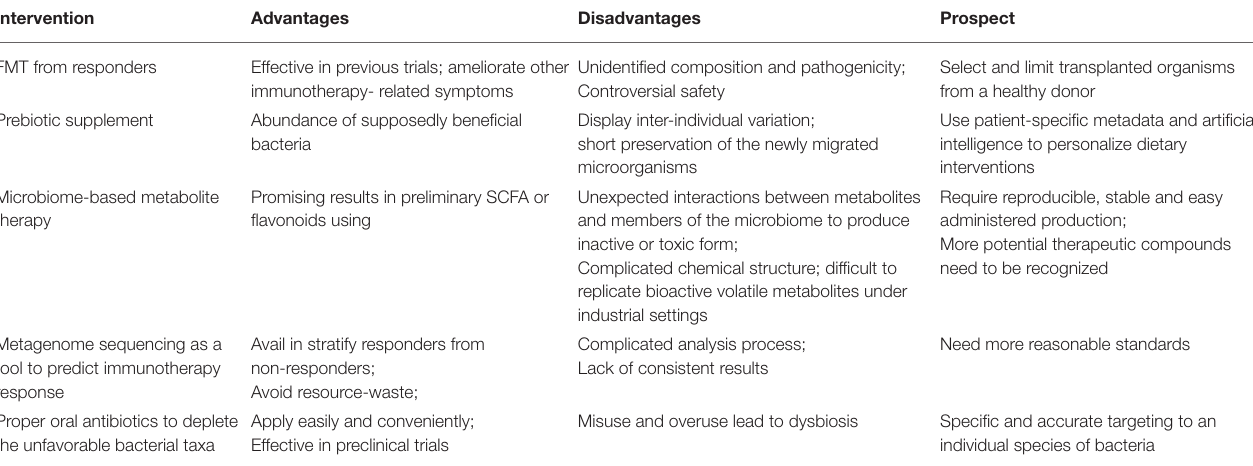
TABLE 2 | The promising strategies to reverse the immunotherapy resistance by manipulating gut microbiota.